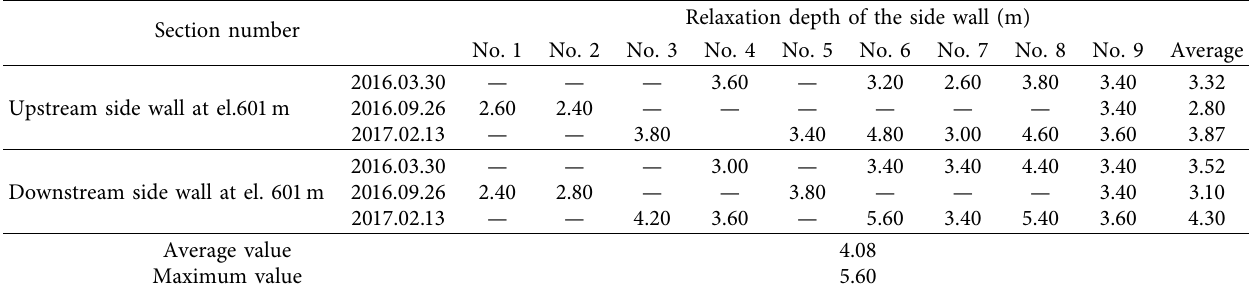
Table 2: Statistical table of acoustic test results at el. 601m.